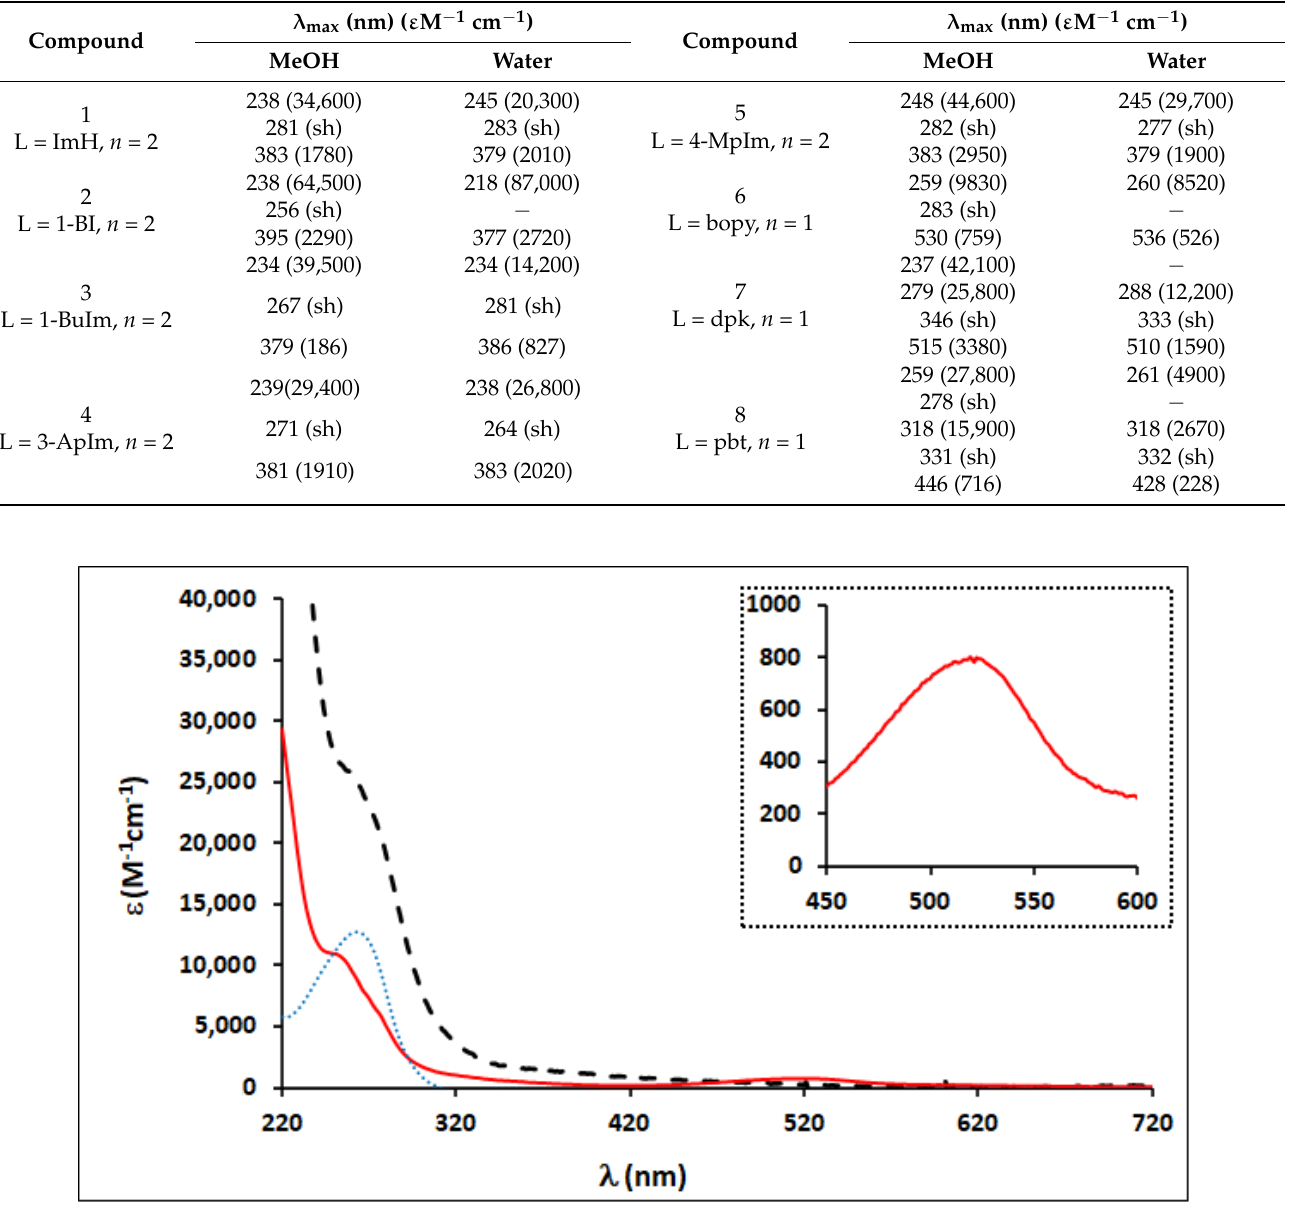
Figure 2. Electronic spectra [Ru( η 5 -C 5 H 5 )( m TPPMSNa)(bopy)][CF 3 SO 3 ] (6) ( ── ) in methanol com- pared with uncoordinated ligand bopy ( ….. ) and [Ru(η 5 -C 5 H 5 )( m TPPMSNa) 2 Cl] ( - - - - ). Inset: detail of charge transfer band.